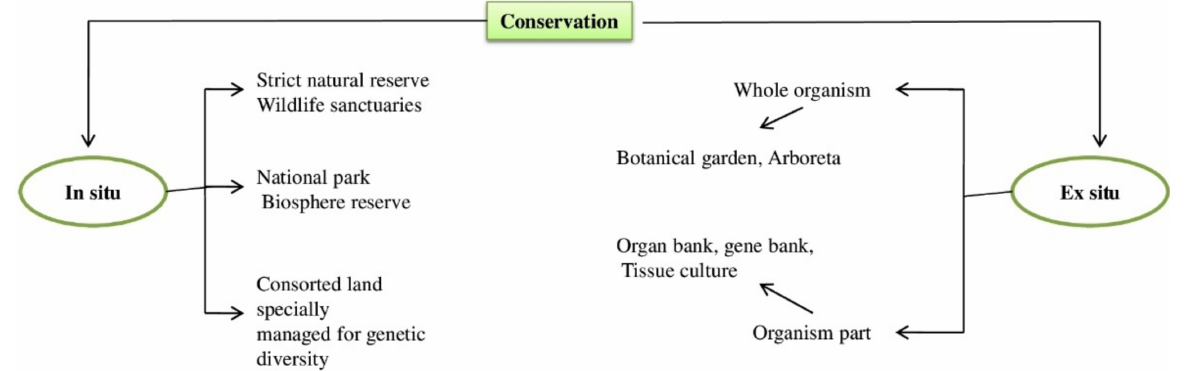
Figure 1. Plant tissue culture approaches in species from the genus Decalepis